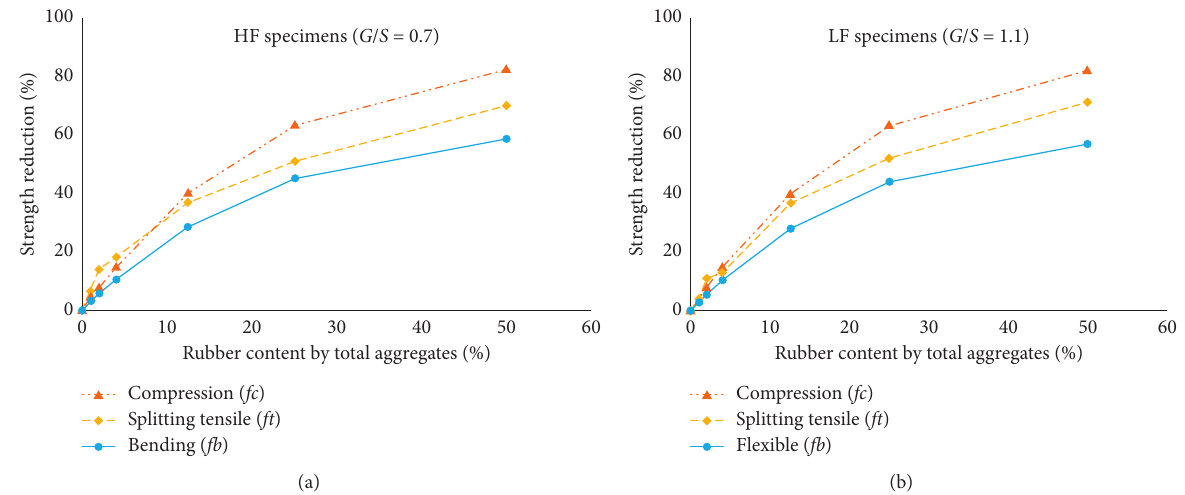
Figure 4: Comparison between strength reduction and silicone rubber content. (a) HF specimens. (b) LF